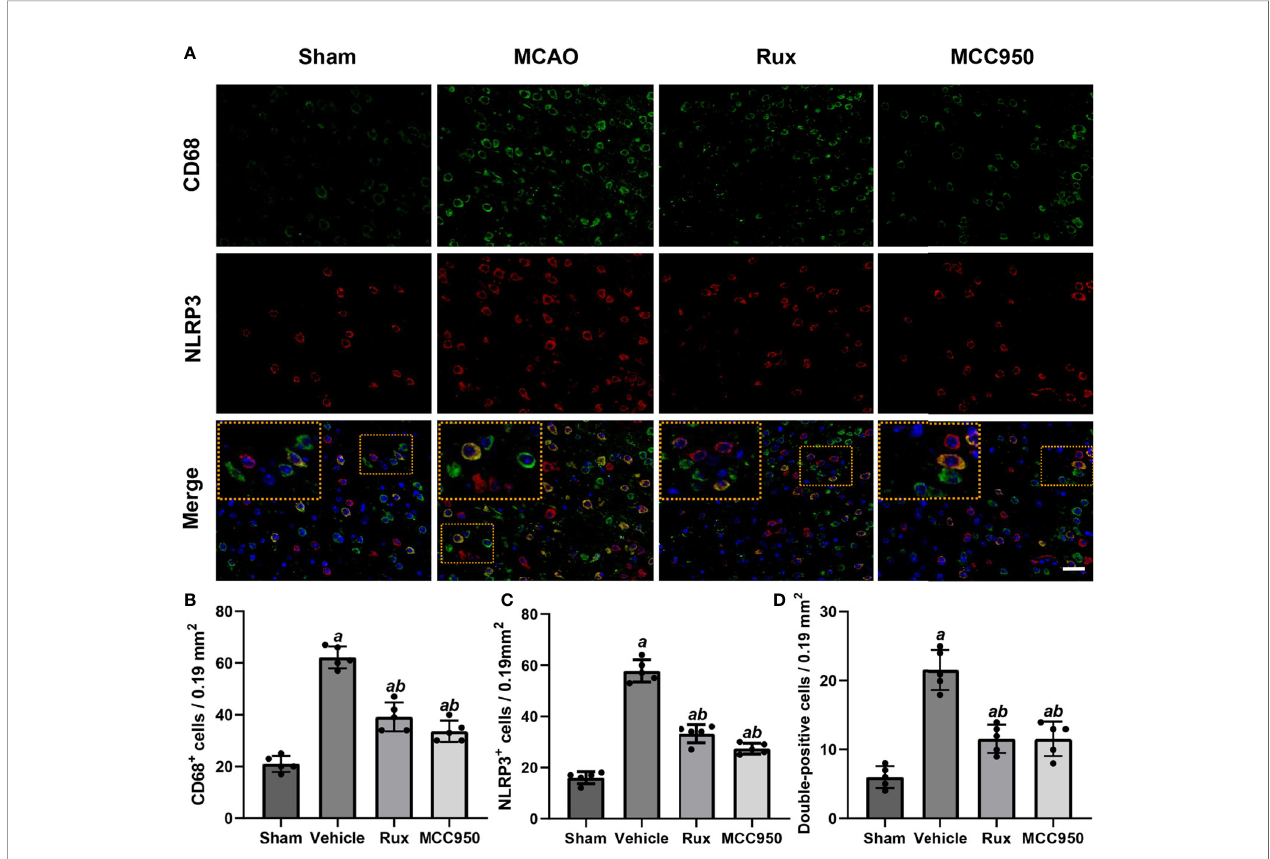
FIGURE 2 | Rux treatment decreased the number of NLRP3 + and CD68 + cells in the ischemic penumbra. (A) Representative images of NLRP3 and CD68 immunostaining in the ischemic penumbra of sham-, vehicle-, Rux- and MCC950-treated mice 3 days after stroke. (B, C) Statistical analysis of NLRP3 + and CD68 + cells. (D) Quanti fi cation of double-positive cells in the peri-ischemic region. Means ± SD. n = 5. a P < 0.01 versus sham; b P < 0.01 versus vehicle. Scale bar: 50